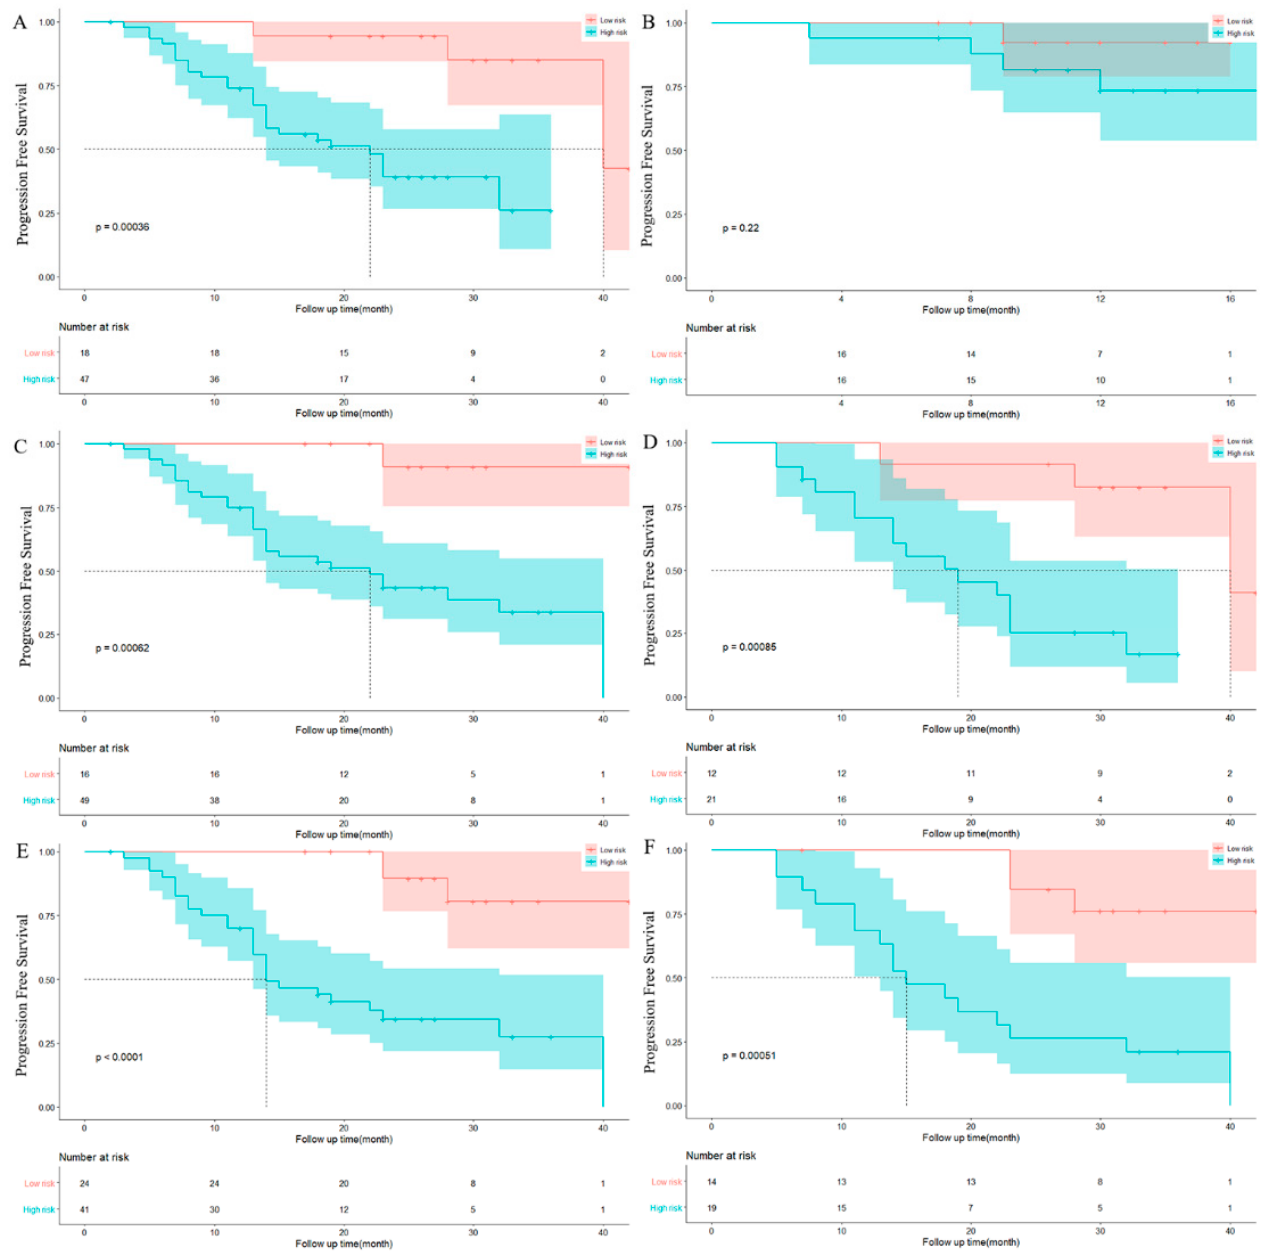
Figure 3. Kaplan–Meier Progression-free survival analysis of high and low risk group. Figure ( A , B ) showed Kaplan–Meier PFS analysis of Cli-mod in the training and validation set; ( C , D ) showed Kaplan–Meier PFS analysis of Rad-mod in training and validation set; ( E , F ) showed Kaplan–Meier PFS analysis of Cli-Rad mod in training and validation